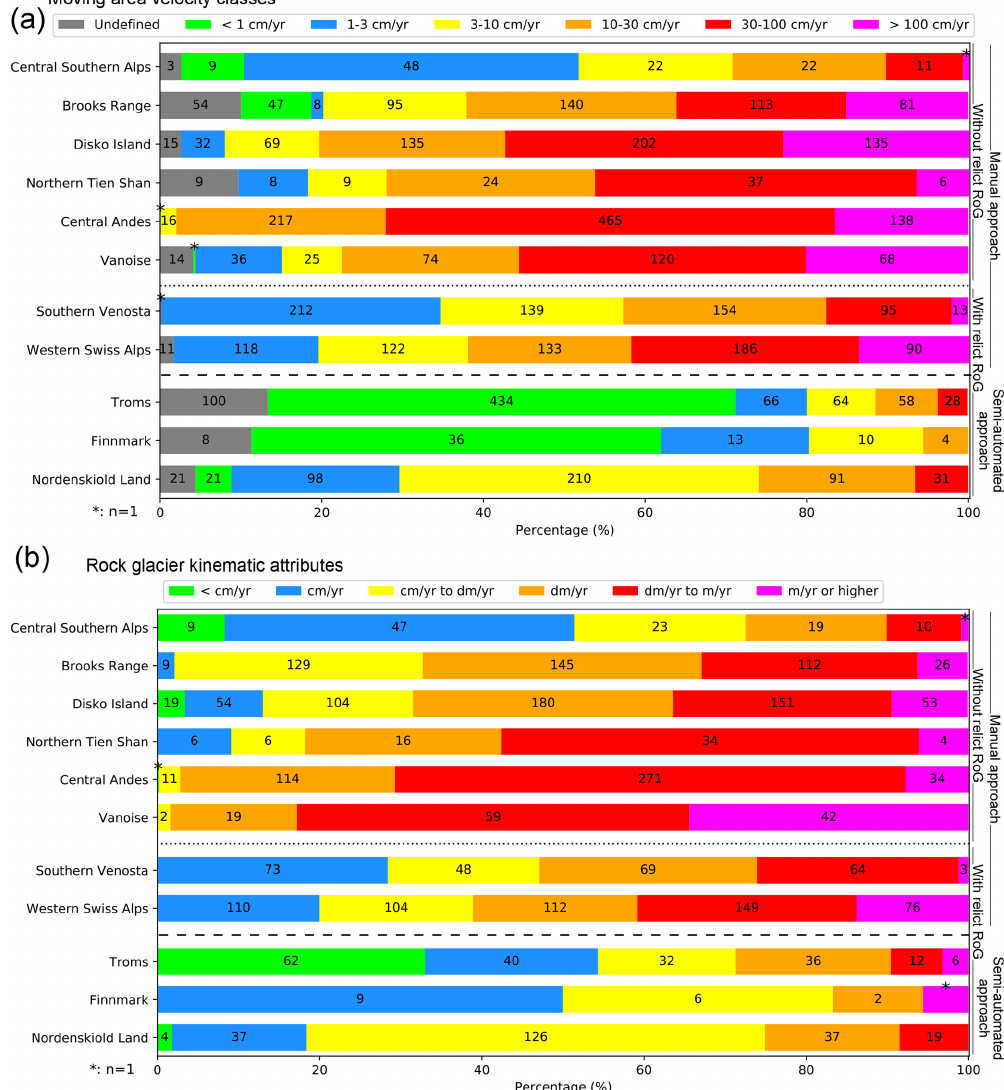
Figure 9. Assigned MA velocity classes (a) and RoG kinematic attributes (b) for each investigated region. Relict landforms are not shown in panel (b) . The length of the bars is proportional to the percentage ( x axis), and the values inside the bars indicate the numbers for each category. Regional inventories are separated according to (i) the method used for mapping the MA (i.e. manual and semi-automated) and (ii) the inclusion or exclusion of relict RoGs. Detailed information on assigned MA velocity classes and RoG kinematic attributes is included in Tables S3 and S4 of the